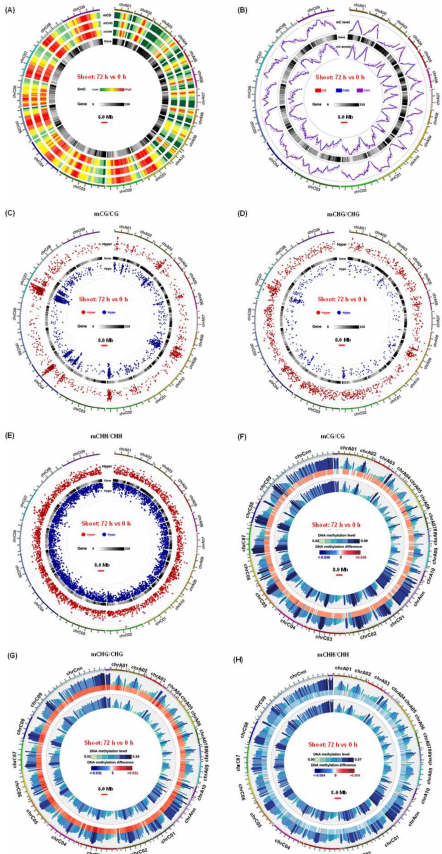
Figure 3. Overview of the genome-wide di ff erential DNA methylation fingerprints in the rapeseed plant shoots between N su ffi ciency and N limitation. ( A ) Circos plots showing the density of di ff erentially methylated regions across the rapeseed genome. In the Circos figure, the terms were as follows outside-to-inside: (i) chromosome, (ii) 5mC density in the CG, (iii) CHG, and (iv) CHH contexts, and (v) gene density of each chromosome in alloteraploid rapeseed. ( B ) Density and level plot of 5mC in CG, CHG, and CHH contexts in the gene bodies on each chromosome. In the Circos figure, the terms were as follows outside-to-inside: (i) chromosome, (ii) 5mC levels in the CG, CHG, and CHH contexts, (iii) gene density, and (iv) 5 mC densities in the CG, CHG, and CHH contexts in the gene bodies. ( C – E ) Density of hypermethylated / hypomethylated regions in the ( C ) CG, ( D ) CHG, outside-to-inside: (i) chromosome, (ii) densities of hypermethylated regions in the CG, CHG, and CHH contexts, (iii) gene density, and (iv) densities of hypomethylated regions in the CG, CHG, and CHH contexts. ( F – H ) Di ff erential methylation levels in the ( F ) CG, ( G ) CHG, and ( H ) CHH contexts